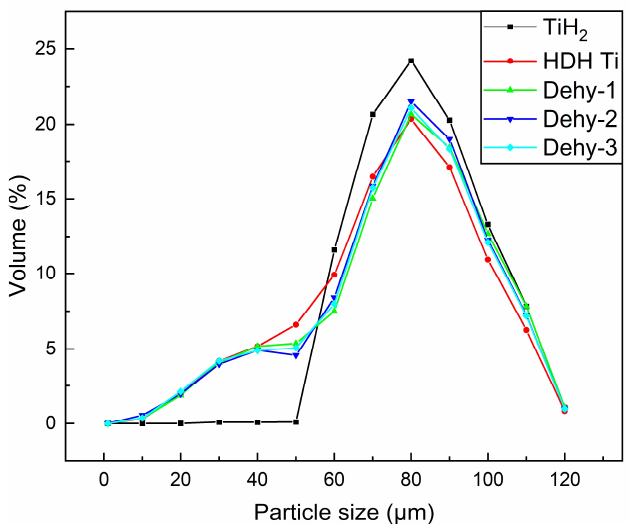
Figure 2. Particle-size distribution of the TiH 2 , Dehy-1, Dehy-2, Dehy-3 and HDH Ti powders. Table 2. Particle size distribution and oxygen content of TiH 2 , Dehy-1, Dehy-2, Dehy-3 and HDH Ti powders.